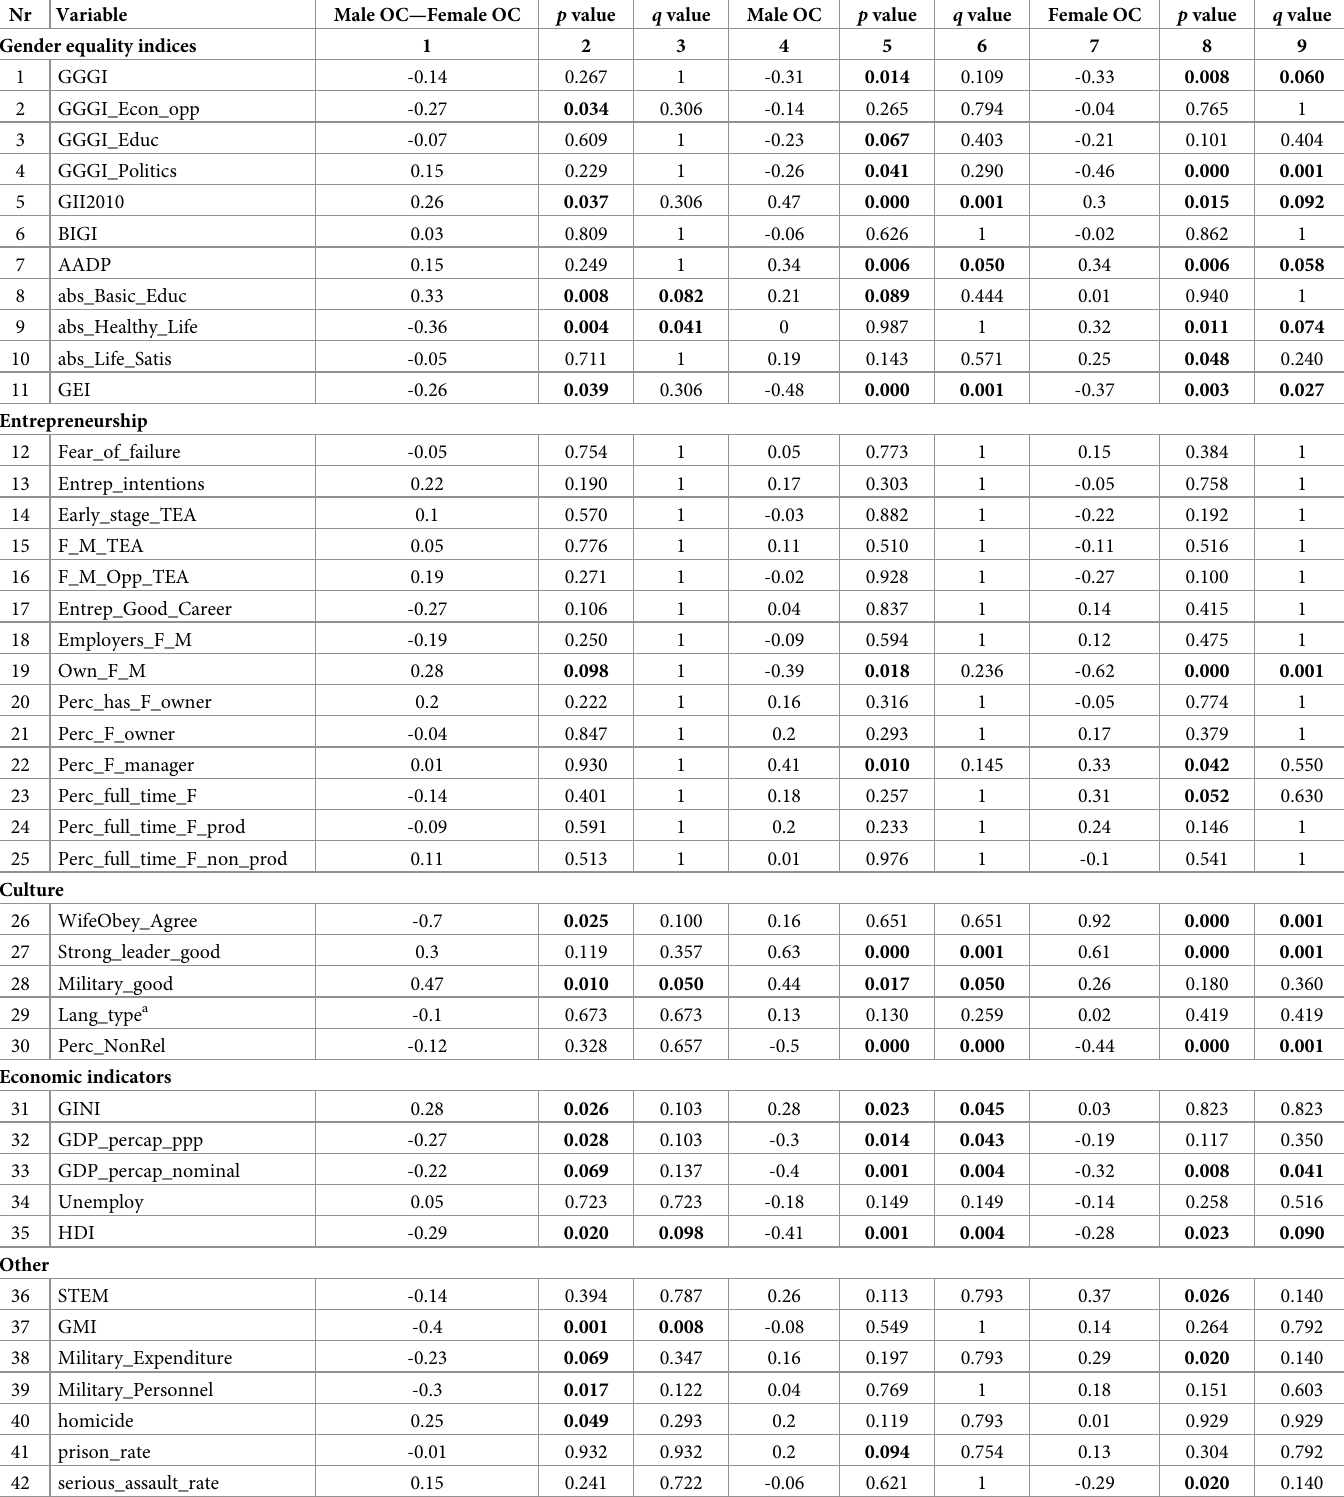
Table 1. Correlation coefficients between country-level indicators and gender gap in OC, male and female